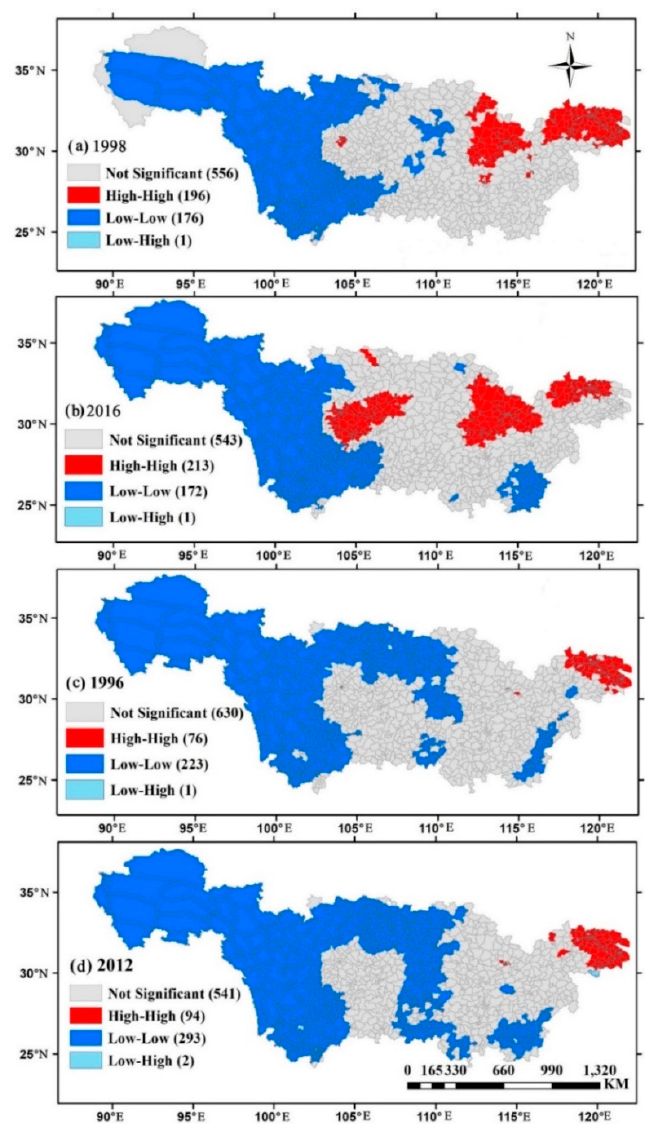
Figure 7. Local indicators of spatial association (LISA) cluster maps of the near-surface PM 2.5 (( a ) 1998 and ( b ) 2016) and NO 2 (( c ) 1996 and ( d ) 2012) concentrations over the 930 county-level cities of the